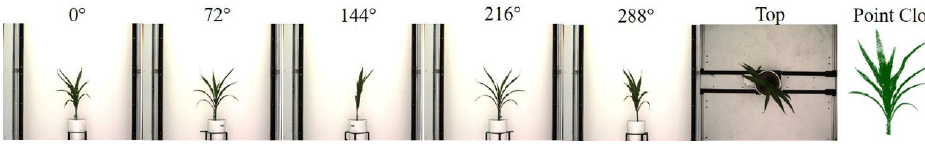
Figure 3. Overlapped images acquired for generating point clouds.